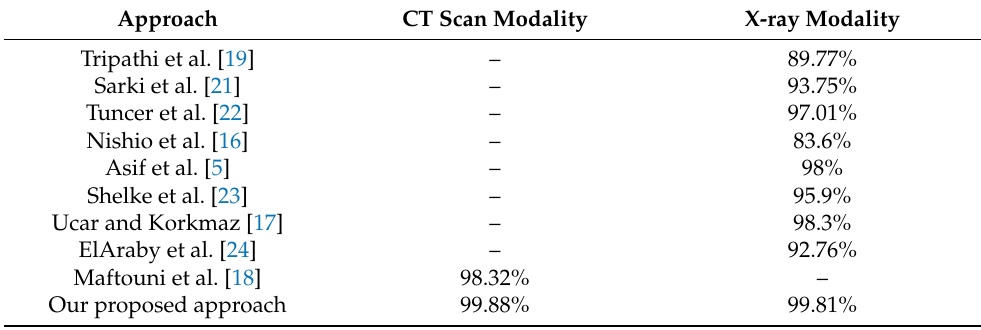
Table 10. Comparison with the